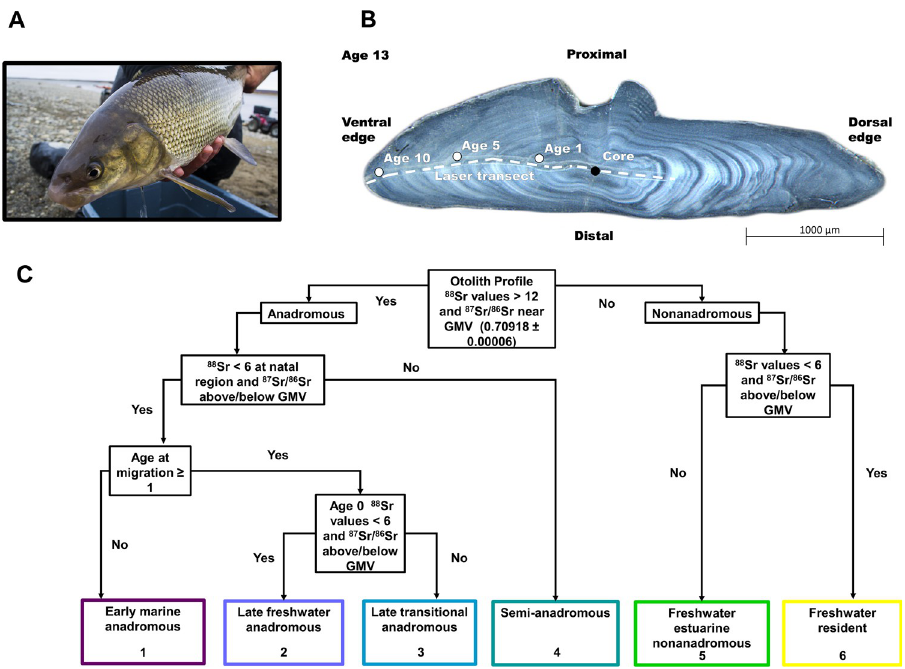
Fig 2. Otolith collection, laser analysis, and life history type classification. (A) Broad Whitefish ( Coregonus nasus ) from the Colville River, AK, USA (Photo credit: Jason C. Leppi), (B) Broad Whitefish otolith showing the core, annuli, and laser ablation path (Photo credit: Dan Bogan), (C) Flow diagram showing the life history classification criteria approach used to group Broad Whitefish.